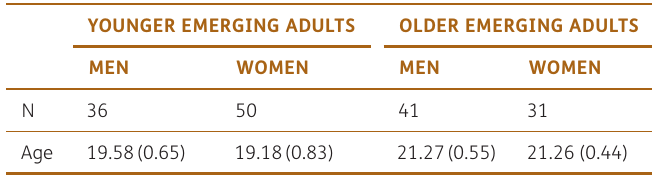
Table 1 Participant Mean Age (Years) and Standard